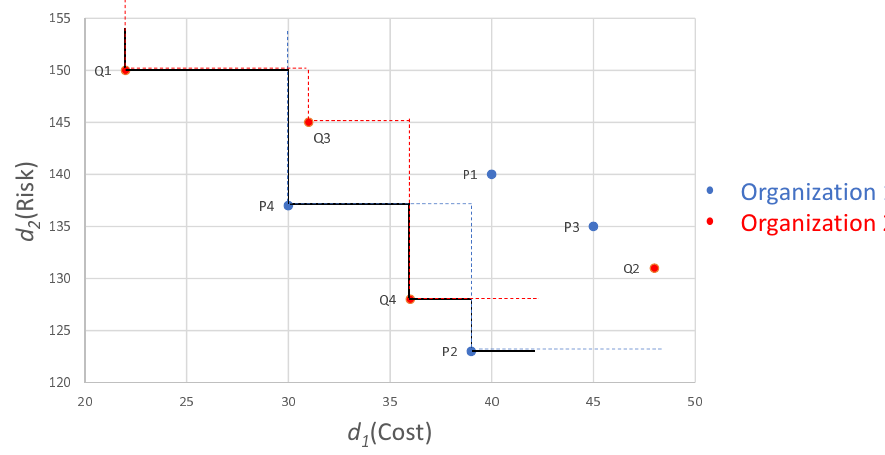
Figure 1. The skyline and multiparty skyline of Organizations 1 and